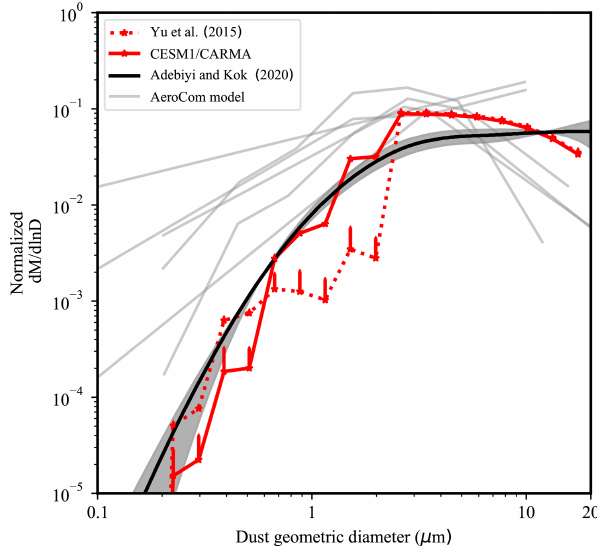
Figure 1. Comparison of the simulated and measured normalized global mean dust size distributions. The dust mass size distributions are divided by the total dust mass integrated over the size range (i.e., the area under each d M / dln D curve). The global and annual mean dust size distribution simulated by CESM1/CARMA with the dust emission parameterization, described in P. F. Yu et al. (2015), is shown by the dashed red line. The simulation by CESM1/CARMA with the modified emission parameterization is shown by the solid red line. Temporal variabilities (1 standard deviation) from P. F. Yu et al. (2015) and CESM1/CARMA are denoted by green and cyan lines. The simulated size distribution by the AeroCom models re- ported in Adebiyi and Kok (2020) is denoted by the gray lines. The measured dust size distribution derived from the global measure- ments reported in Adebiyi and Kok (2020) is denoted by the solid black line. The shading represent the 95% confidence